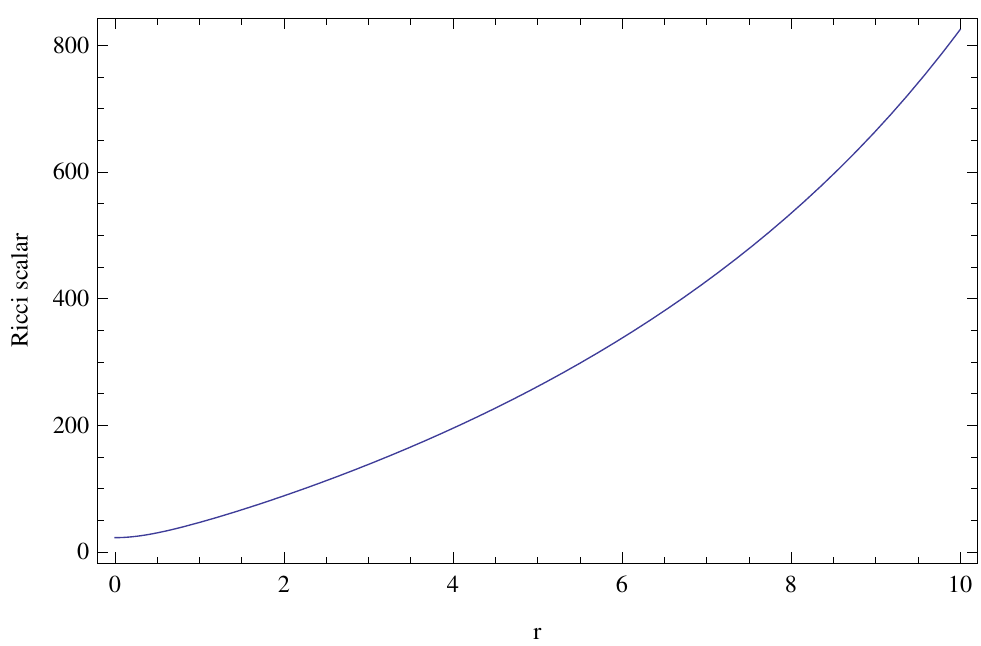
Figure 8. The Ricci scalar is plotted against the radial parameter r , for quintessence matter ( ω = − 1 for the values of constants λ = 0.1, C 1 = 0.01, C 2 = 0.5, C 3 =